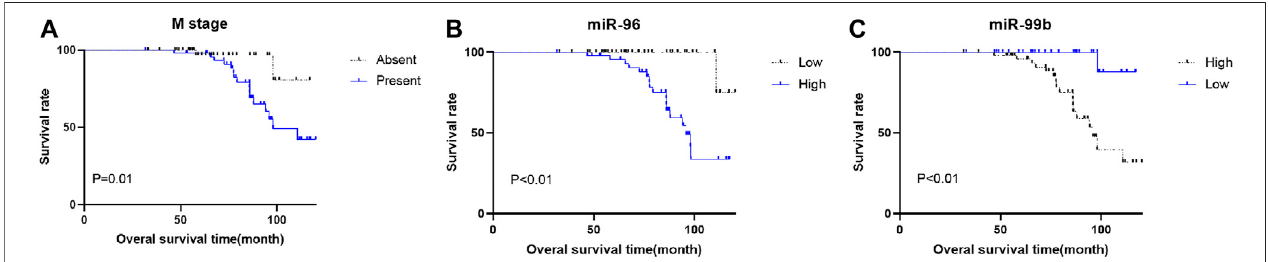
FIGURE 5 | Kaplan – Meier survival curves for CRC patients. Patients were categorized into two groups based on the medium expression levels of miRNAs ( n (cid:2) 45 respectively). (A) there is a signi fi cant difference in OS between patients with and without metastasis. (B) different miR-96 expression is signi fi cantly correlated with OS. C, different miR-99b expression is signi fi cantly correlated with OS.